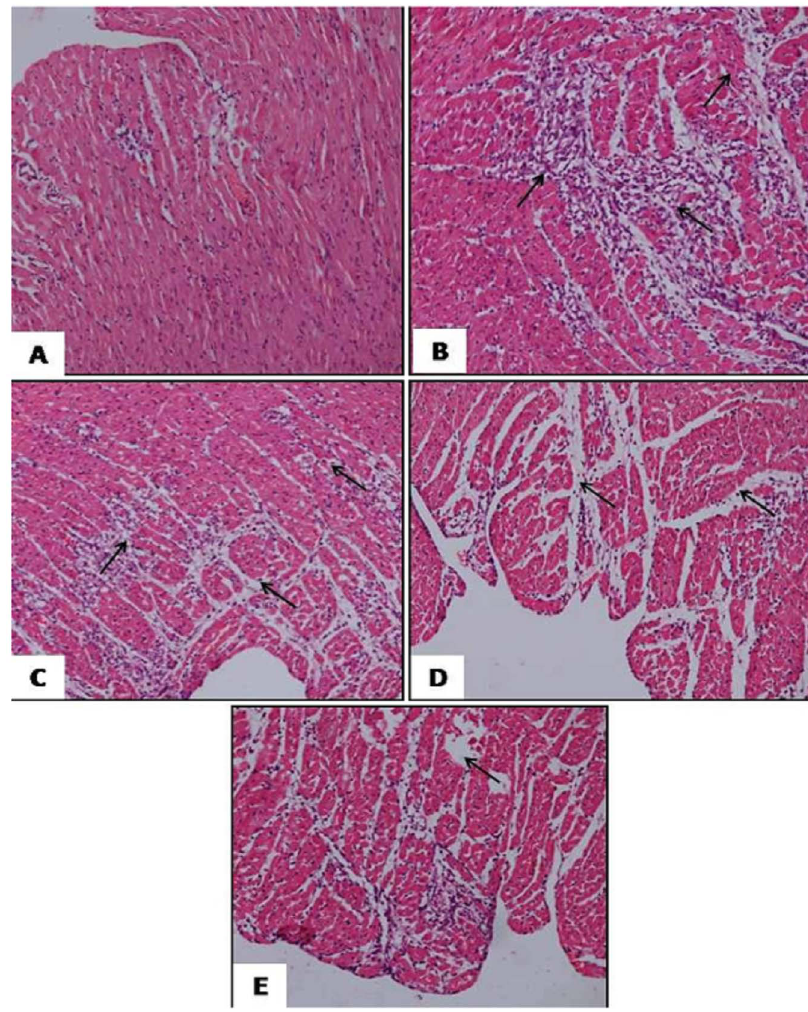
Figure 3. Photomicrograph showing the histopathological changes in the rat myocardium. (A) represents haematoxylin and eosin staining [(H&E) 6 200] in diabetic sham group, B diabetic ischaemia/reperfusion (I/R) group (H&E 6 200), (C) diabetic I/R + hesperidin treatment (100 mg/kg) (H&E 6 200), (D) diabetic I/R + GW9662 (1 mg/kg) (H&E 6 200) and (E) diabetic I/R rats + GW9662 + hesperidin (H&E 6 200).